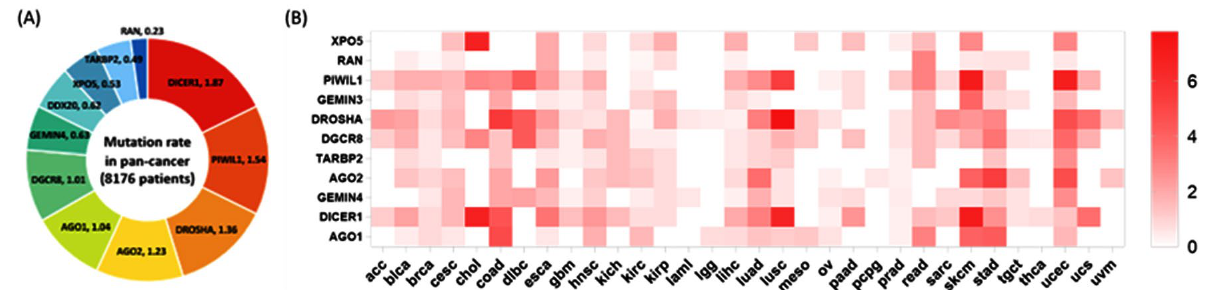
Figure 6. The mutation rate of the 11 genes across the pan-cancer study. ( A ) The left panel shows the proportion of mutations of 11 genes in all cancers included in the study. The percentage of mutant samples is shown for each gene. ( B ) Heatmap depicting the mutation rate of the 11 genes in the 33 cancer types included in the pan-cancer study. Higher color intensity indicates a higher mutation rate. ACC (adrenocortocal carcinoma), BLCA (bladder urothelial carcinoma), BRCA (breast ductal and lobular carcinoma), CESC (cervical carcinoma), CHOL (cholangiocarcinoma), COAD (colorectal adenocarcinoma), DLBC (diffuse large B-cell lymphoma), ESCA (esophageal carcinoma), GBM (gliobastoma multiforme), HNSC (head and neck squamous cell carcinoma), KICH (kidney chromophobe carcinoma), KIRC (kidney clear cell carcinoma), KIRP (kidney papillary cell carcinoma), LGG (lower grade glioma), LIHC (liver hepatocellular carcinoma), LUAD (lung adenocarcinoma), LUSC (lung squamous cell carcinoma), MESO (mesothelioma), OV (ovarian serous adenocarcinoma), PAAD (pancreatic ductal adenocarcinoma), PCPG (paraganglioma and pheochromocytoma), PRAD (prostate adenocarcinoma), READ (rectum adenocarcinoma), SARC (sarcoma), SKCM (skin cuta- neous melanoma), STAD (stomach–gastric adenocarcinoma), TCGT (testicular germ cell cancer), THCA (thyroid papillary carcinoma), UCEC (uterine corpus endometroid carcinoma), UCS (uterine carcinosarcoma), and UVM (uveal melanoma). THYM (thymoma) in the TCGA pan-cancer data is not shown as there was not any mutation of the studied